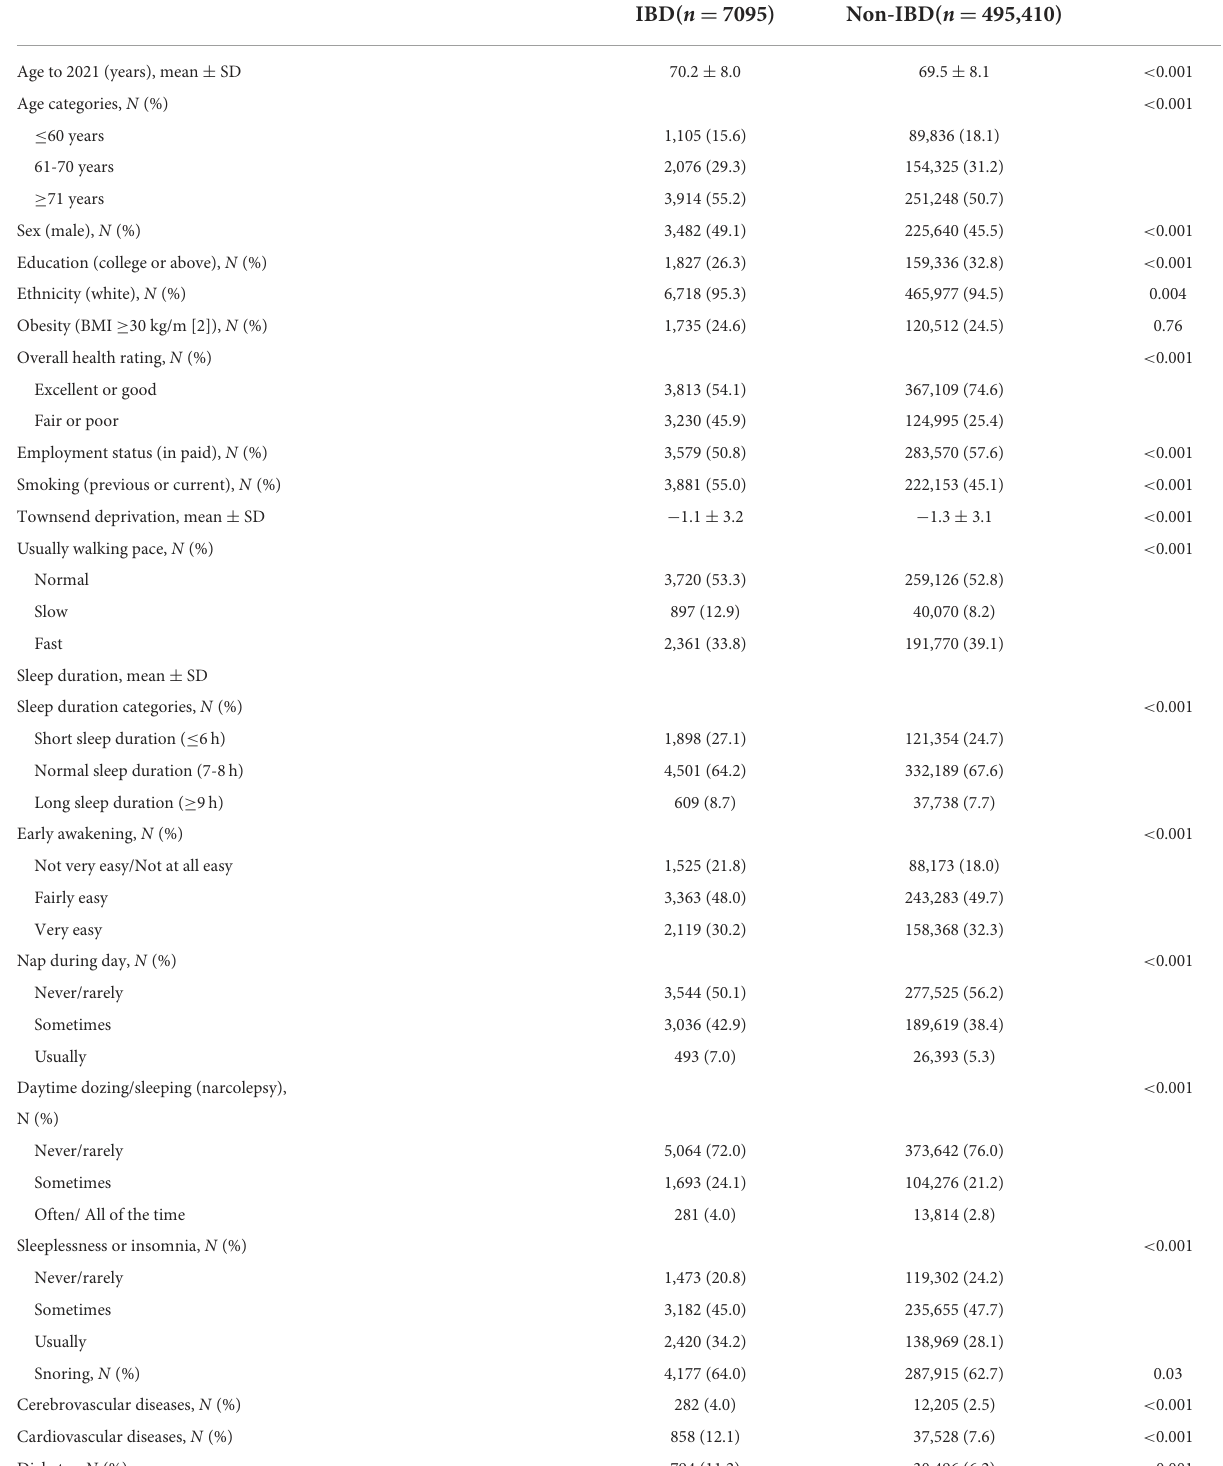
TABLE 1 Characteristics of UK Biobank